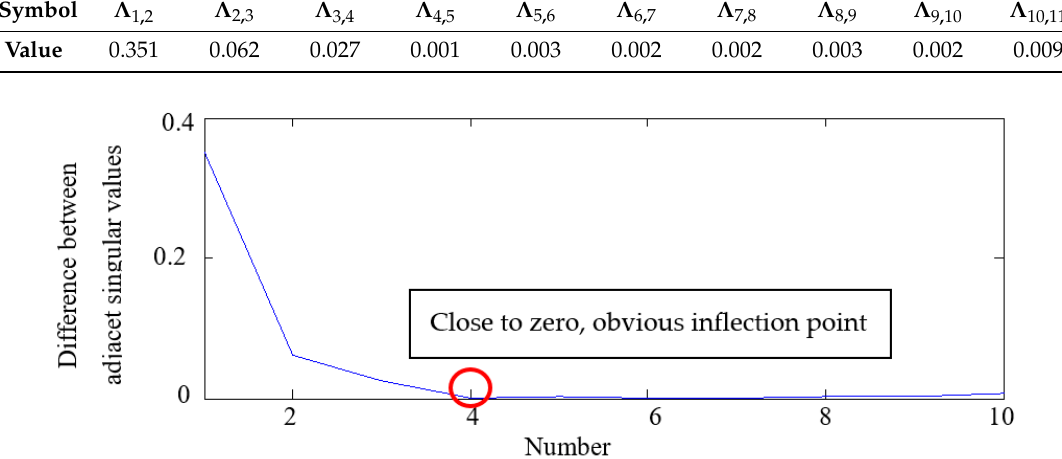
Figure 10. A line graph of adjacent singular value differences obtained by the demodulation-based empirical wavelet transform-singular value decomposition (DEWT-SVD) method.